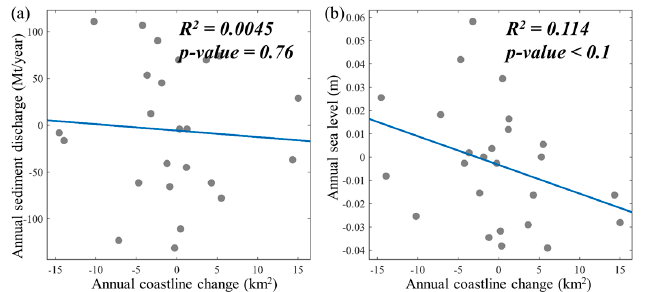
Figure 14. In fl uencing factors analysis after removing the data with dramatic changes. ( a ) Annual sediment discharge; ( b ) Annual sea level.